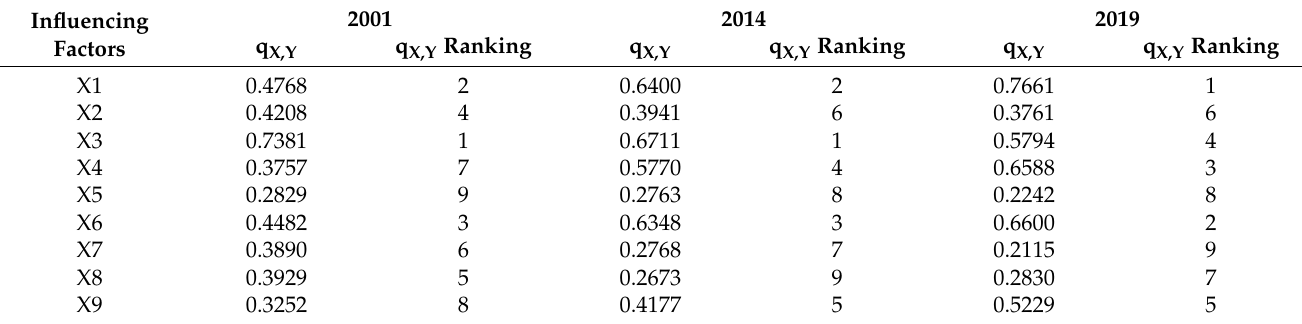
Table 4. Detection results of factors influencing the development performance of small